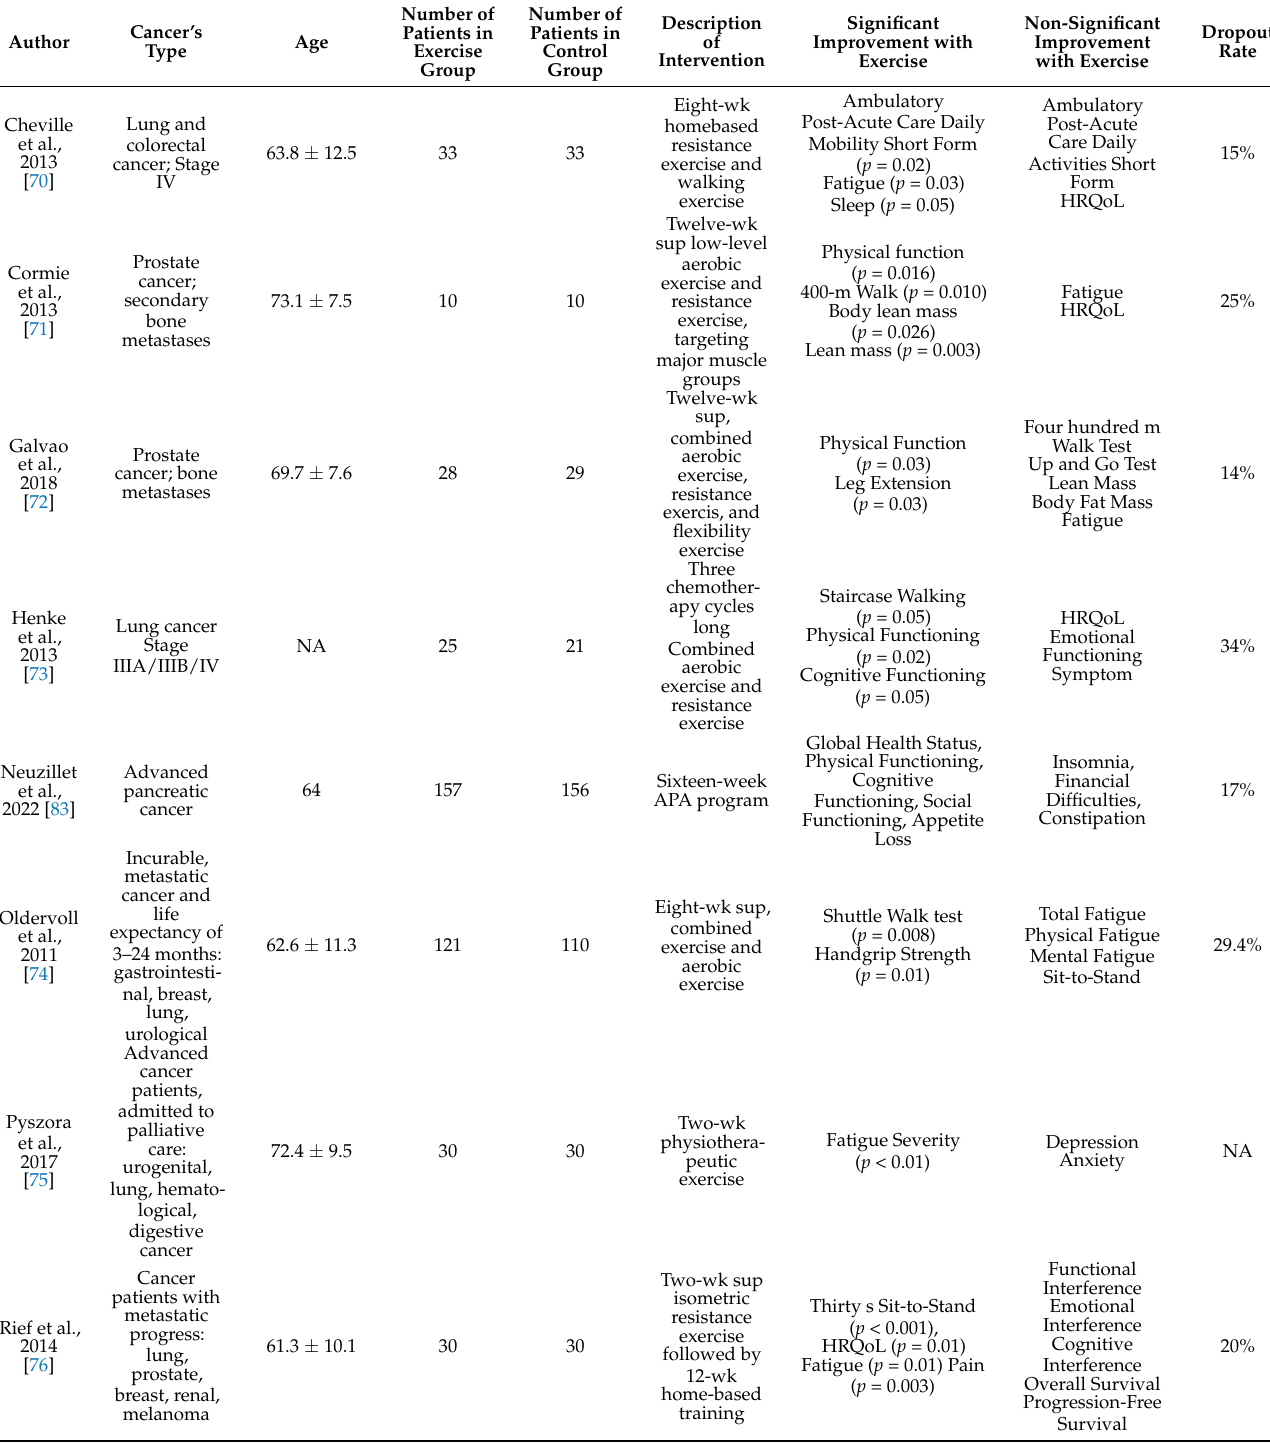
Table 2. Recent controlled studies about the safety and efficacy of physical activity interventions in advanced